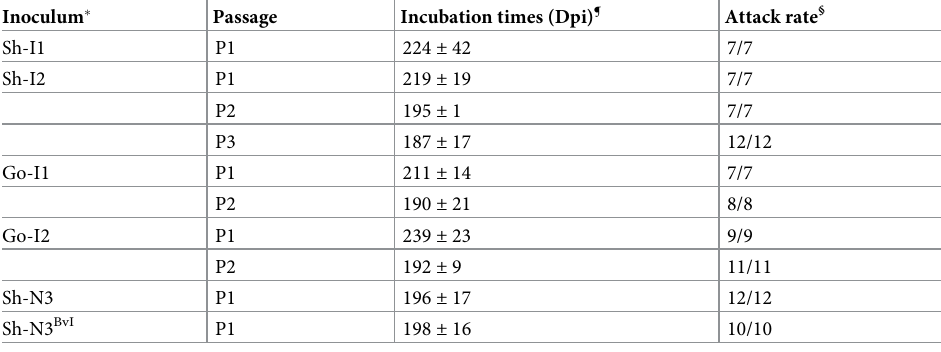
Table 2. Transmission of atypical scrapie from sheep and goat isolates to tg338 mice.